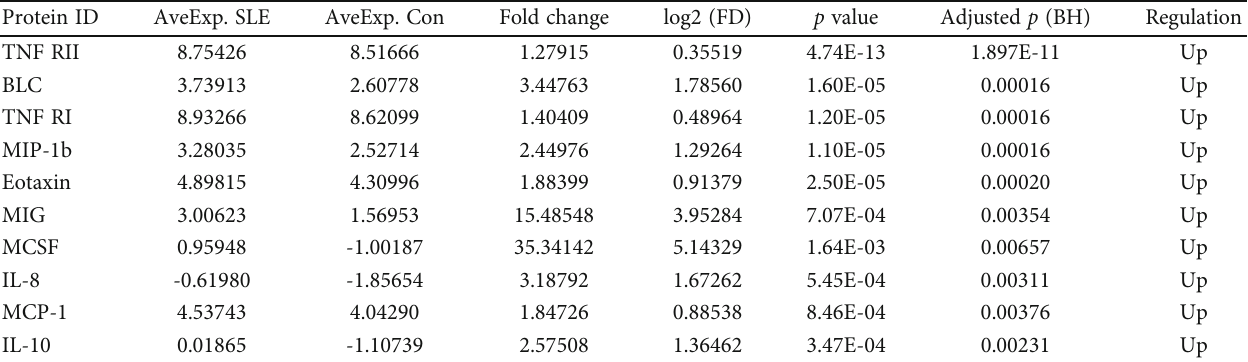
Figure 1: Levels of quanti fi ed proteins. (a) Quanti fi ed levels of the 40 proteins. Upregulation (red dot) was FD > 1 : 2 , downregulation (green dot) was FD < 0 : 83 , and other proteins (grey dot) were regarded as there was no signi fi cant di ff erence between SLE patients and healthy controls. (b) Volcano plot of the 40 proteins and statistical signi fi cance between patients with SLE and healthy controls. Adjusted p value was determined by method “ BH ” based on the original p value. (c) Volcano plot of the 40 proteins and di ff erences between SLE patients with and without renal involvement. (d) Heatmap of the ten di ff erently expressed proteins. Table 2: Proteins which showed statistical di ff erences between the SLE group and control